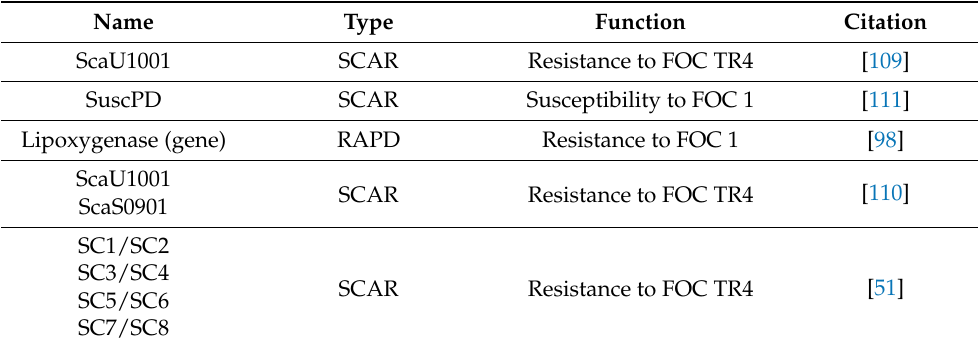
Table 3. Molecular markers associated with banana breeding strategies to Fusarium wilt in articles carried out in the last ten years.